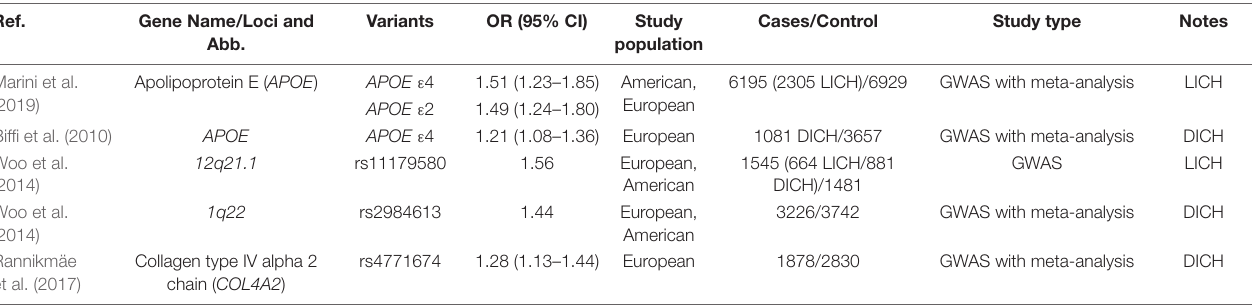
TABLE 2 | Genetic variants related to ICH risk in different location (GWAS).